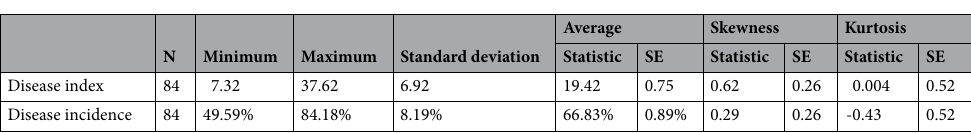
Table 1. Statistical description of the disease incidence and disease index values based on the investigation of corn Fusarium sheath rot in the field.